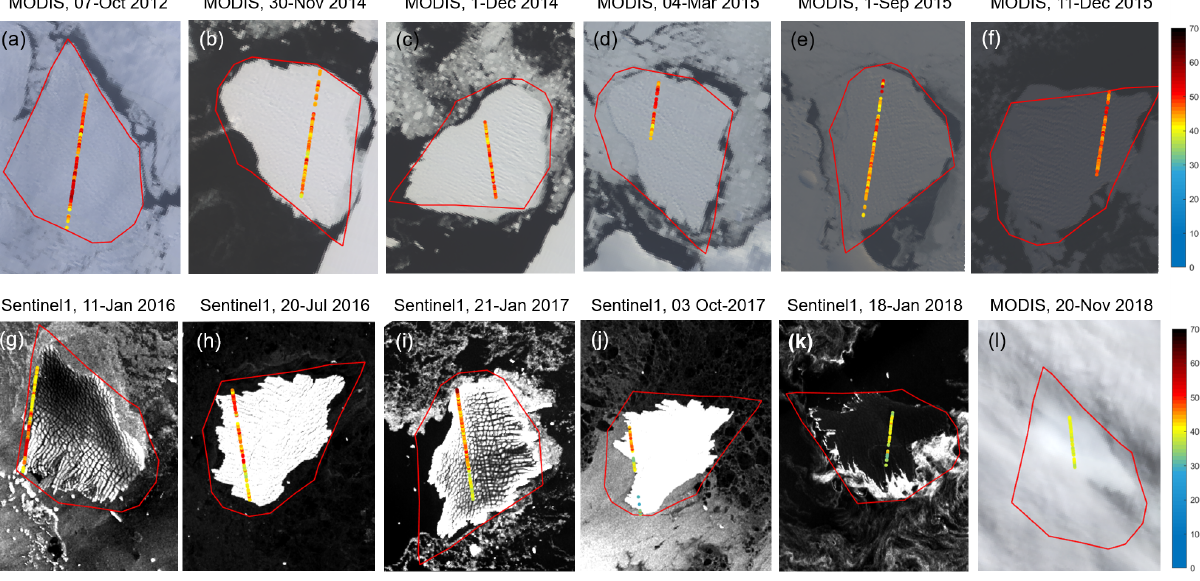
Figure 3. Satellite imagery with near-coincident CryoSat-2 tracks of iceberg freeboard and the manually transformed initial polygon shape plotted on top. The initial polygons are used to determine the relative position of each new